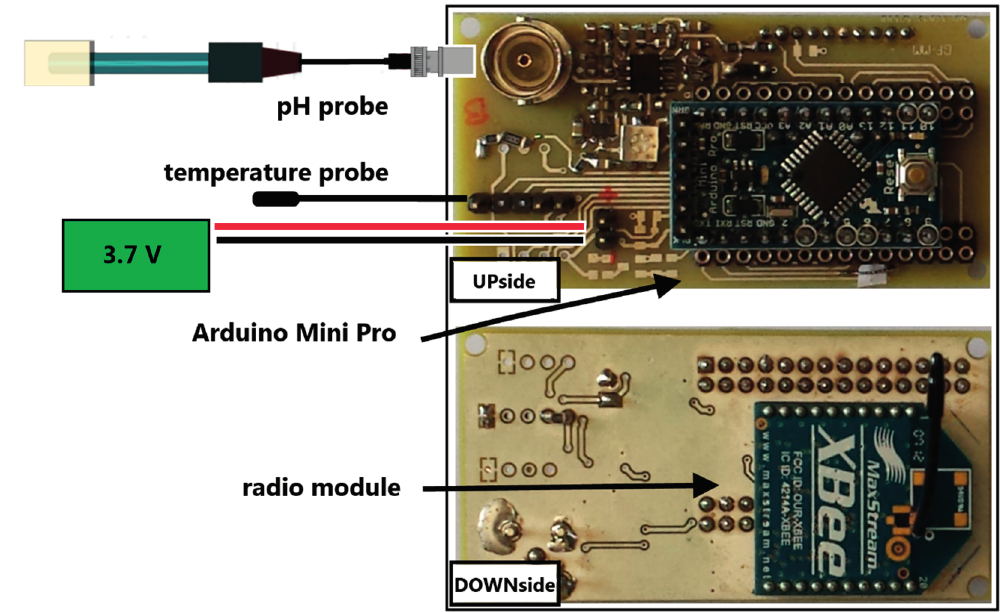
Figure 2. Scheme of WineDuino node hardware.